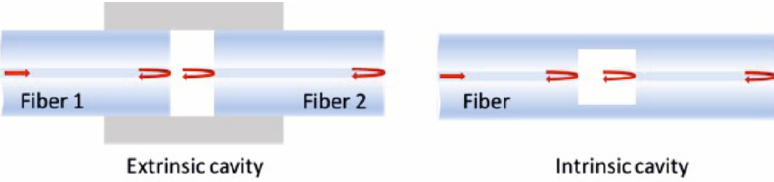
Figure 1. Schematics of typical extrinsic and intrinsic cavities in Fabry–Perot (FP) fiber-based sensors.